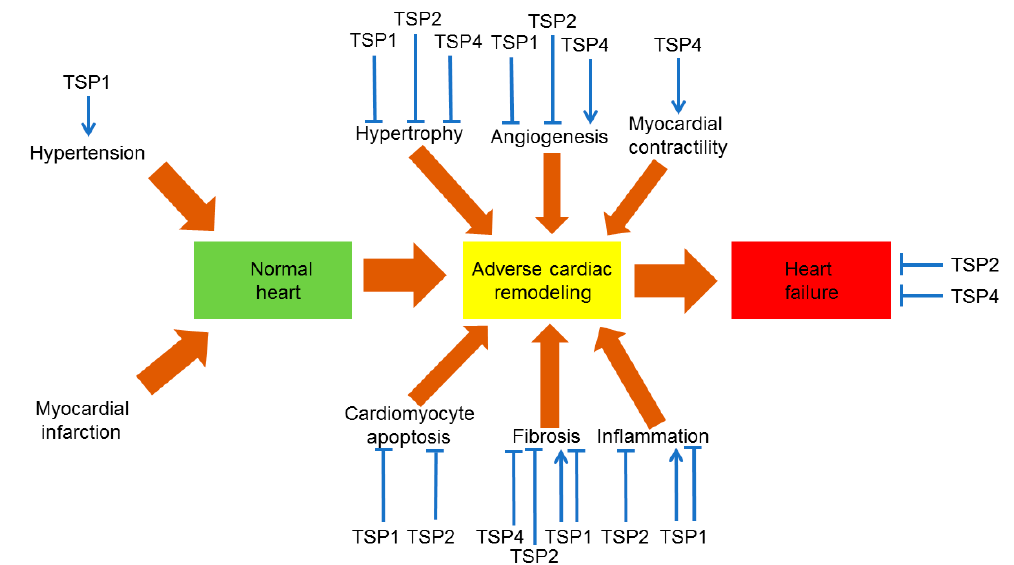
Figure 2. The role of thrombospondins (TSPs) in cardiovascular pathology. TSP1, TSP2, and TSP4 are the best preclinically studied TSPs in experimental models of cardiovascular pathology involving knockout or overexpression of these TSPs. Sharp arrows define stimulatory effects. Other type of arrows defines inhibitory effects. Table 1. The role of thrombospondins in cardiovascular physiology and pathology